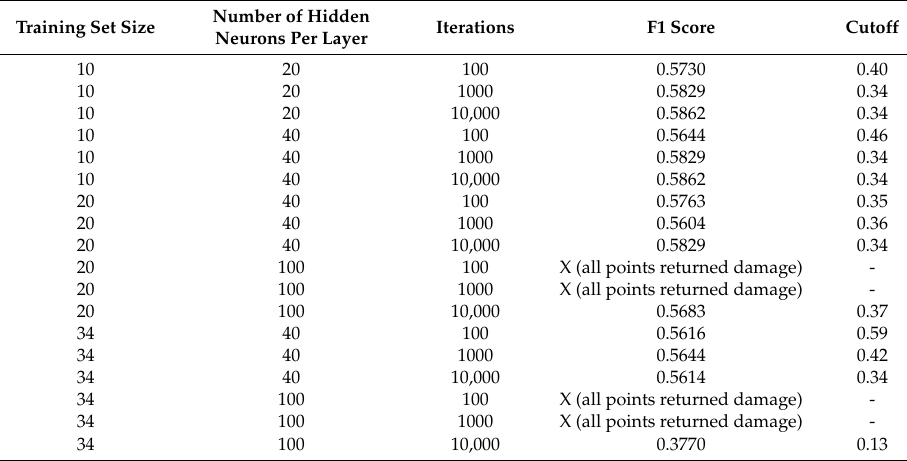
Table 3. Results from preliminary parameter